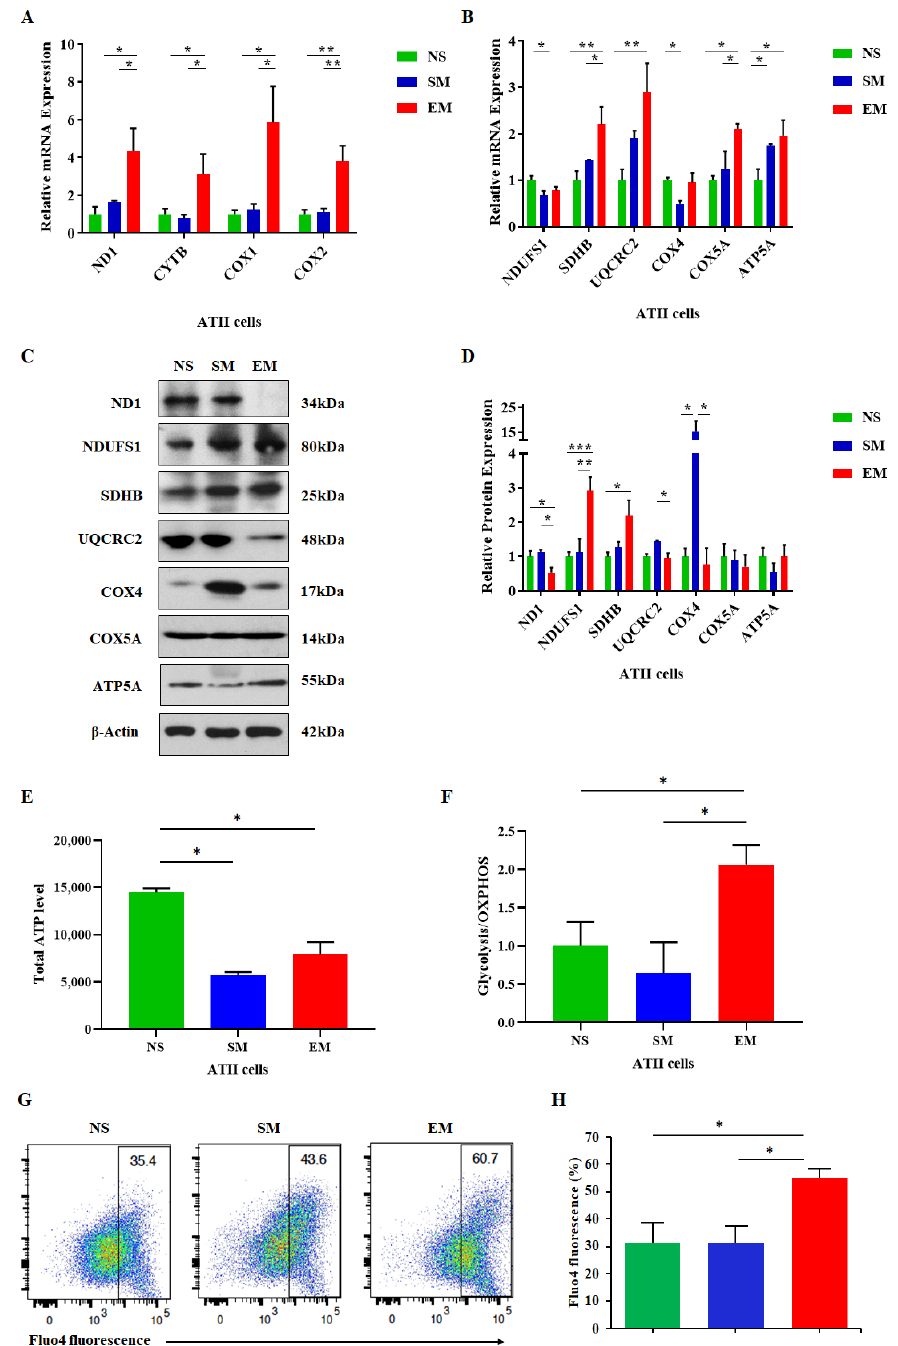
Figure 3. High expression of mitochondria-encoded genes in ATII cells in emphysema. Freshly isolated ATII cells from nonsmokers (NS), smokers (SM), and emphysema patients EM) were used